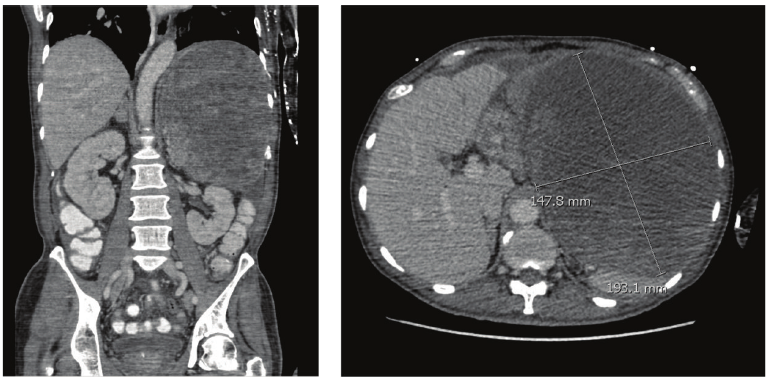
Figure 1: Abdominal CT scans demonstrating a 20 cm mass in the left upper quadrant retroperitoneum.